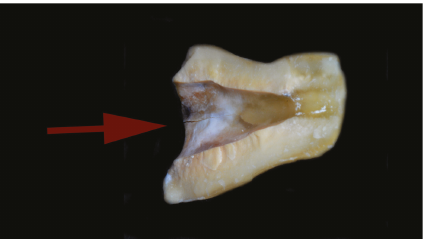
Figure 12: An incomplete cracking line (arrow) involved the coronal area of the small